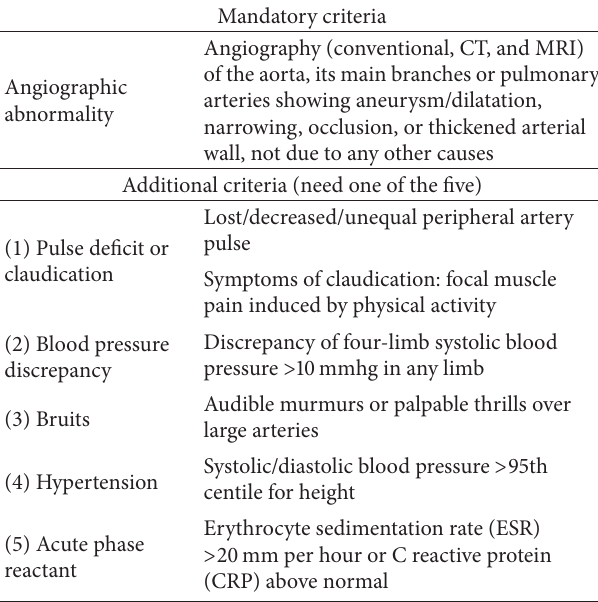
Table 1: EULAR/PRINTO/PRES criteria and classification defini- tion of Takayasu Arteritis.